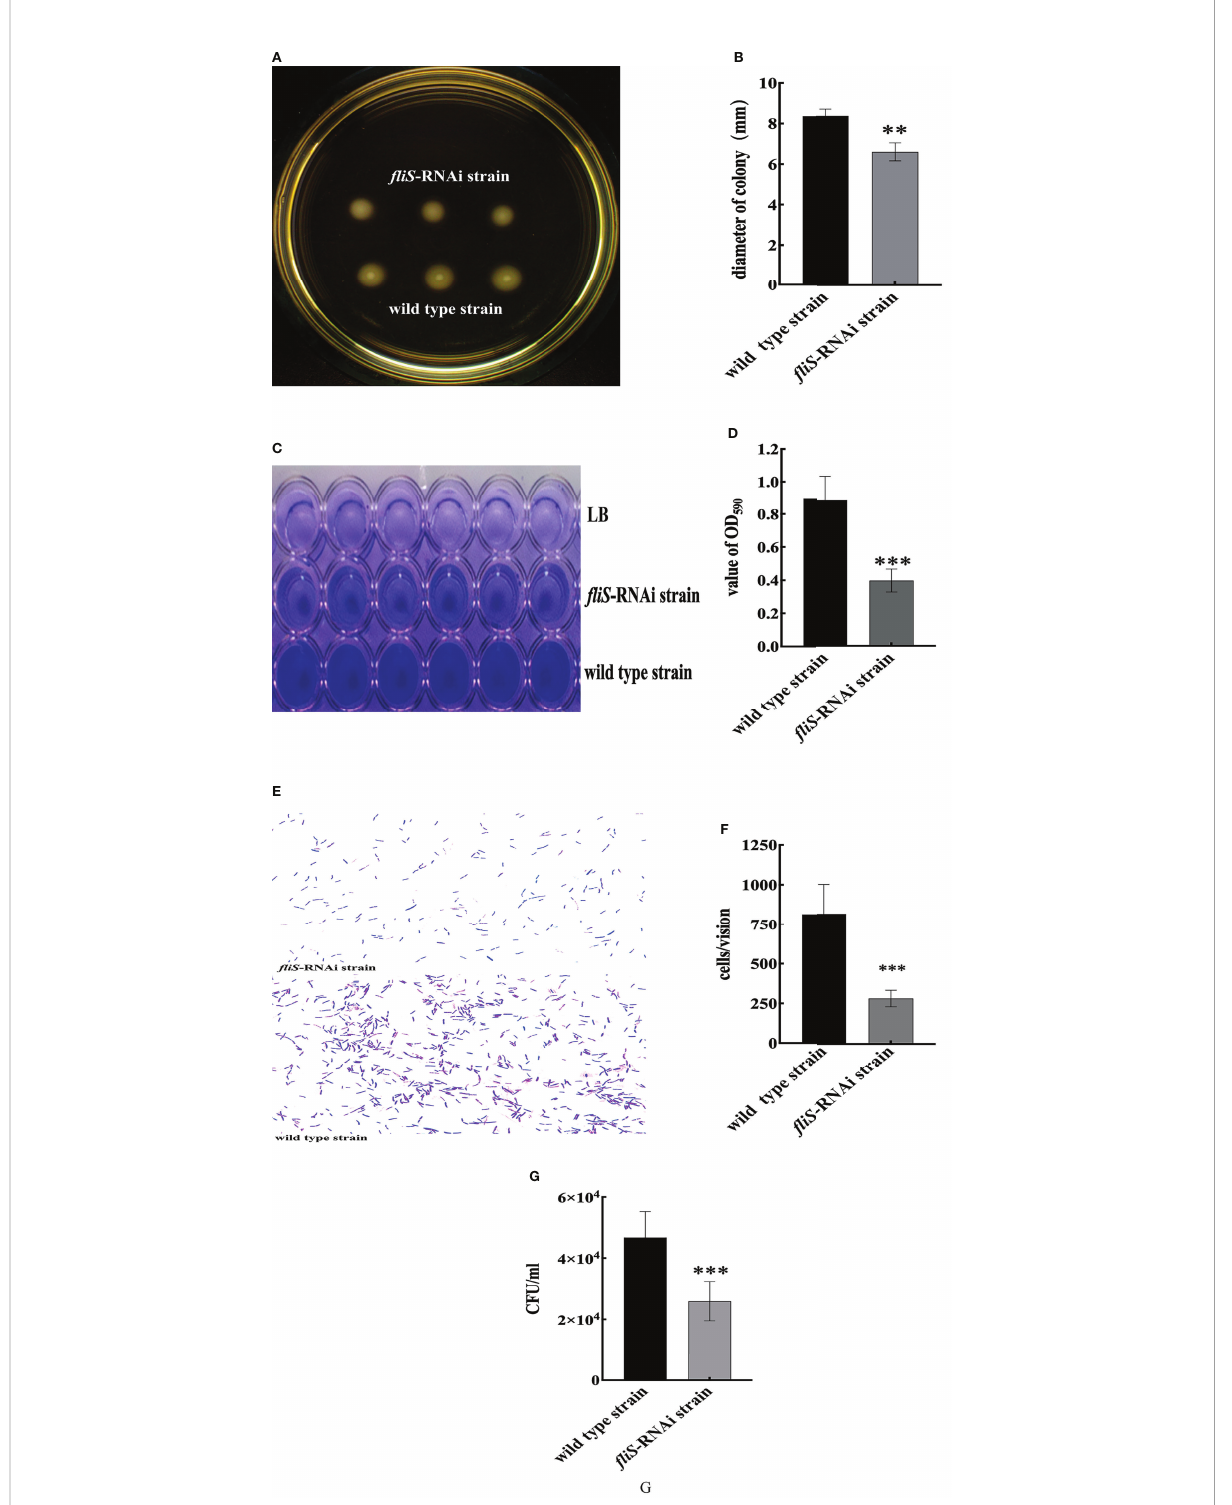
FIGURE 2 Characteristics of two P. plecoglossicida strains. (A) Colonies of wild type and fl iS -RNAi strain swarms on soft agar plates. (B) Colony diameters of wild type and fl iS -RNAi strains. (C) Bio fi lm of wild type and fl iS -RNAi strains. (D) Bio fi lm formation ability of wild type and fl iS -RNAi strains. (E) Adhering bacteria under the microscope. (F) Adhesion ability of wild type and fl iS -RNAi strains. (G) Chemotaxis capacity of wild type and fl iS -RNAi strains. Data are mean ± SD. * p < 0. 05, ** p < 0. 01, *** p < 0.